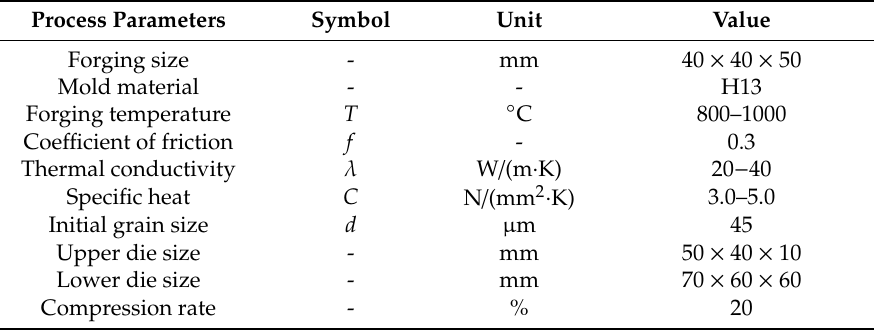
Table 1. The setting of relevant simulation parameters of forging